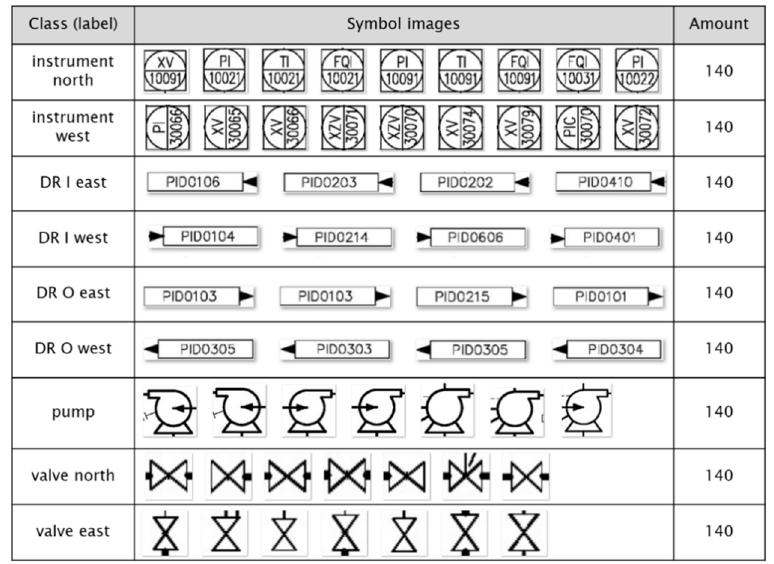
Figure 5. Training data used for the recognition of symbols with the help of a deep learning model.